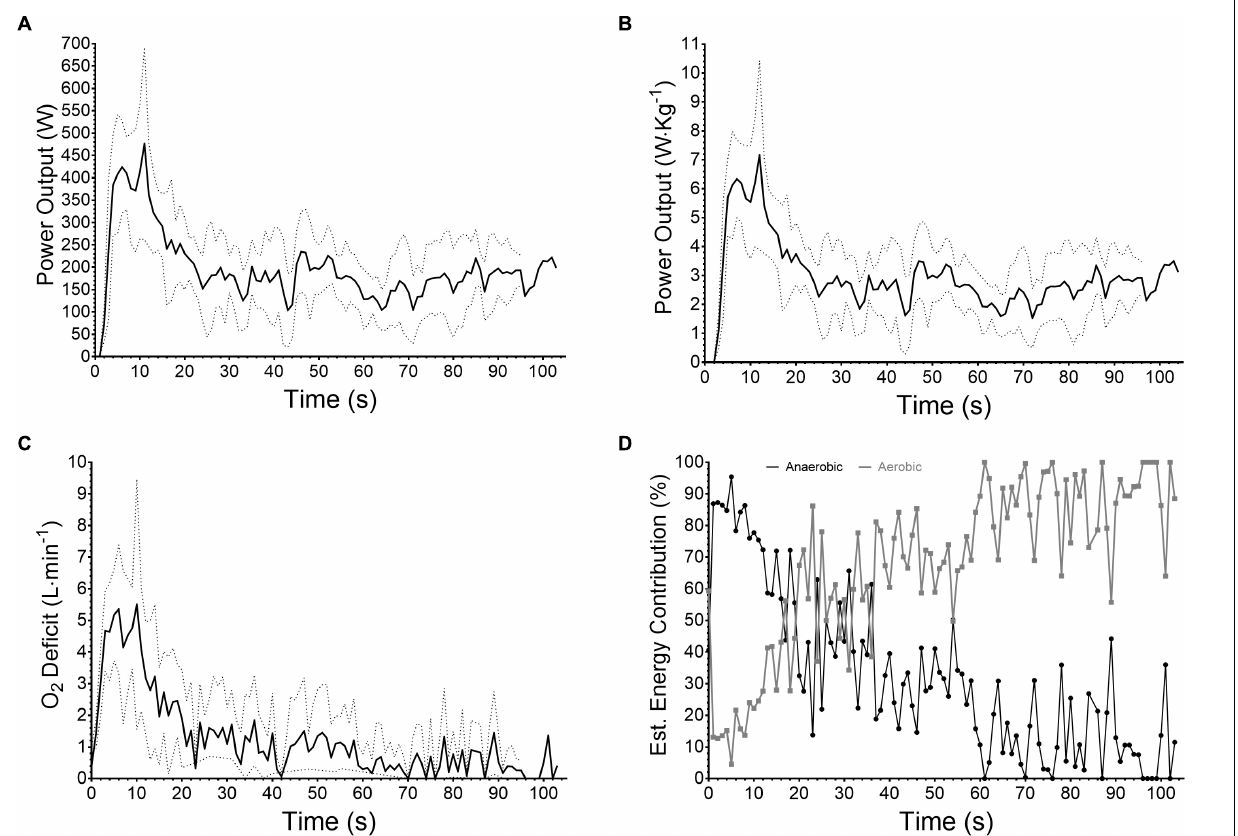
FIGURE 3 | Mean ± SD ( n = 8) for (A) absolute power output (W), (B) relative power output (W · kg − 1 ), (C) O 2 deficit (L · min − 1 ) and (D) mean aerobic-anaerobic contribution to exercise